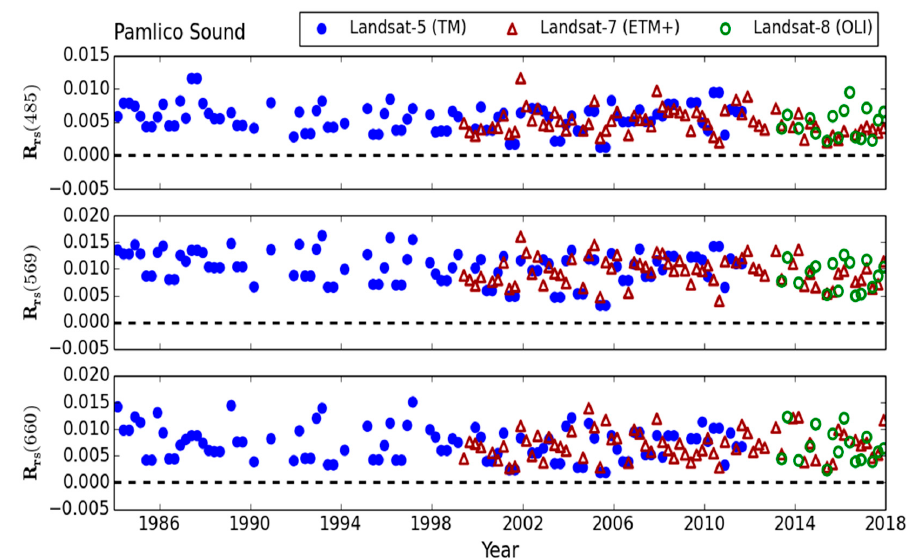
Figure 11. Seasonal composites of R rs products derived from Landsat-5 (solid circles), Landsat-7 (triangle), and Landsat-8 (hollow circles) in Pamlico Sound, North Carolina (35.1963N, 76.2670W). The composites were obtained by taking the median of retrievals in each season. The images processed via SeaDAS. The product consistency can be inferred in the overlapping periods indicating the utility of long-term Landsat data record for aquatic science studies. Note that because of the differences in the temporal sampling (i.e., eight days) and considering various tidal stages, a robust analysis of product consistency is not possible.